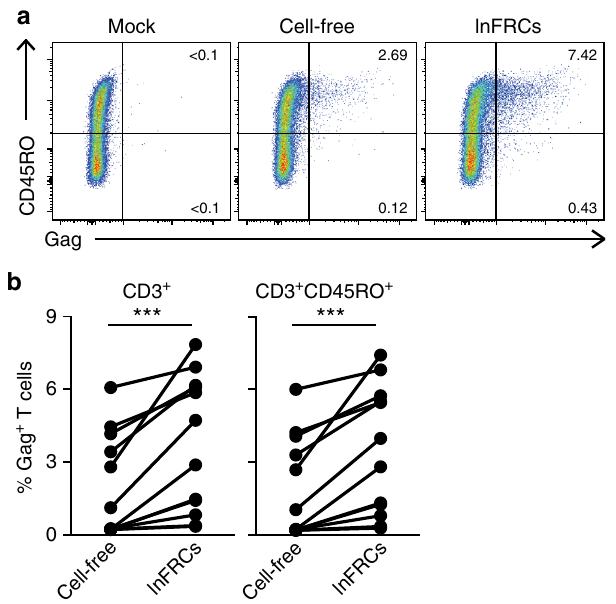
Fig. 2 FRCs mediate trans-infection of memory CD4 + T cells. lnFRCs were cultured in the presence of HIV-1 NL4-3 (100 ng p24) for 2 h, washed extensively, and cocultured with PHA-stimulated peripheral blood leukocytes (PBLs) for 4 days. For the cell-free condition, PHA-stimulated PBLs were inoculated with the same amount of input virus and cultured for 4 days without washing off the inoculum. Gag expression among CD3 + CD45RO + and CD3 + CD45RO − cells were analyzed by fl ow cytometry. a A representative set of the results obtained using one pair of lnFRCs and PBLs is shown. b Data represent the results of experiments performed using 12 different pairs of lnFRCs and PBLs. lnFRCs derived from four different donors were paired with PBLs isolated from one of eleven different donors. The p- values were determined using Wilcoxon matched-pairs signed rank test. *** p < condition used, lnFRCs mediated trans-infection of A3.01T cells more ef fi ciently than imDCs and mDCs (Supplementary Fig. 2B).